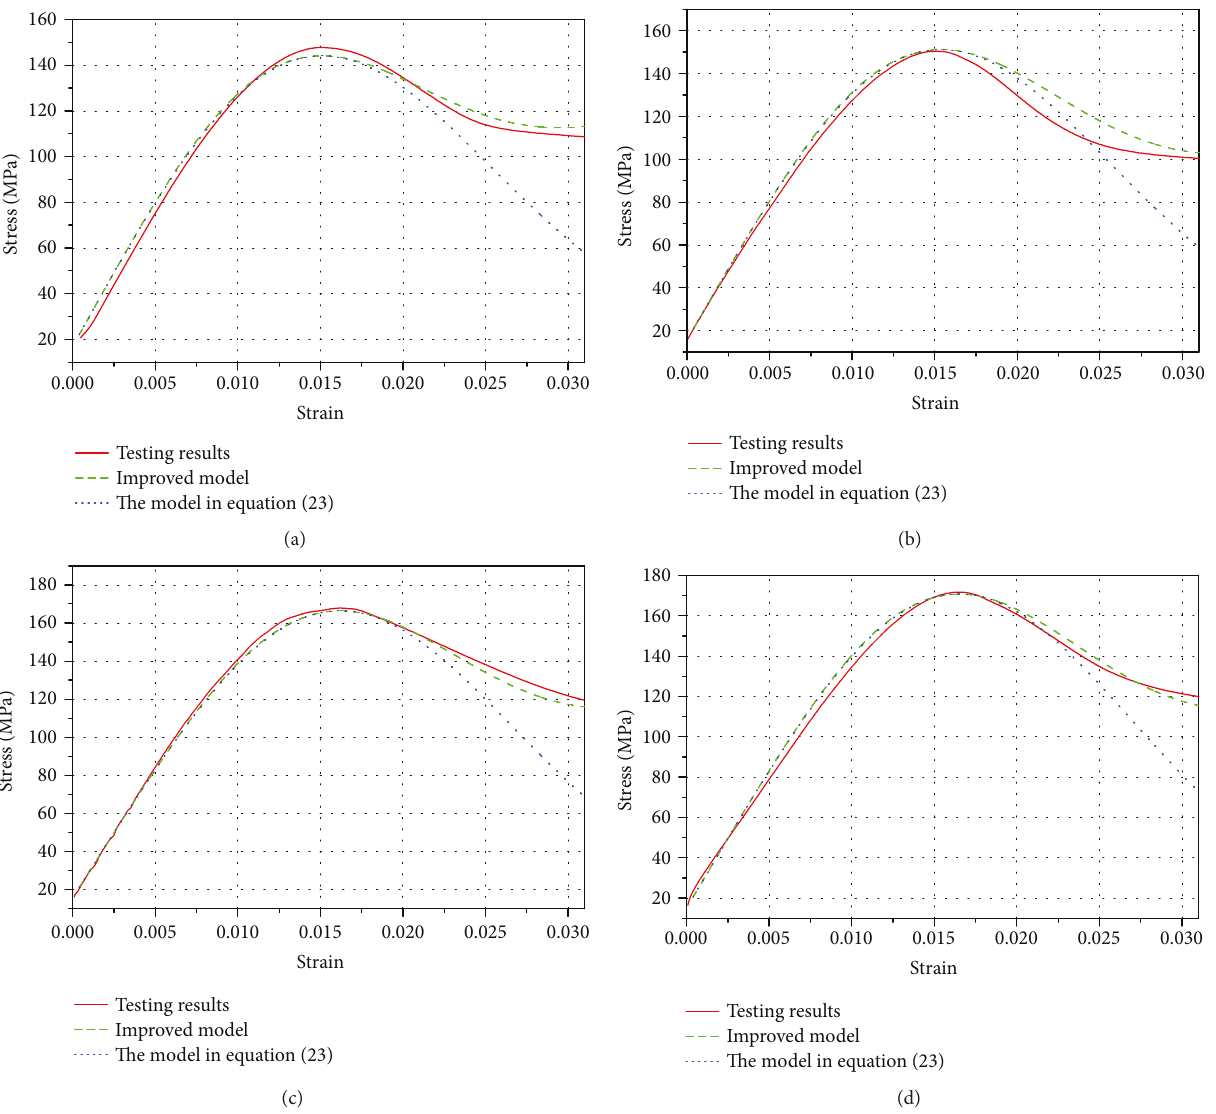
Figure 5: Theoretical curves and test curves of sandstone with di ff erent chemical corrosions under a con fi ning pressure of 30 MPa. (a) H solutions, (b) NaOH solution, (c) distilled water, and (d) natural